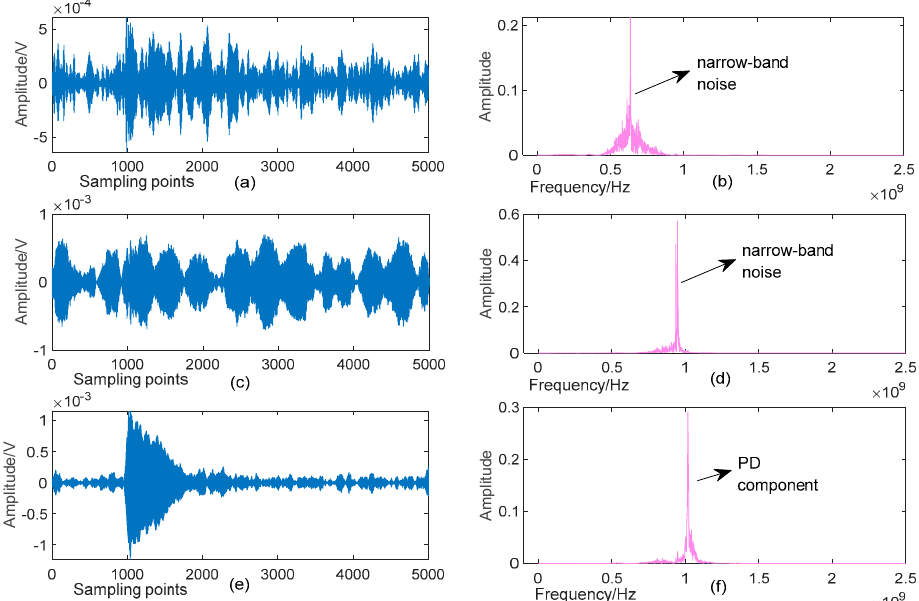
Figure 15. Some decomposed BLIMFs of Type 4 signal: ( a ) The 4th BLIMF; ( b ) Spectrum of ( a ); ( c ) The 5th BLIMF; ( d ) Spectrum of ( c ); ( e ) The 6th BLIMF; ( f ) Spectrum of ( e ).